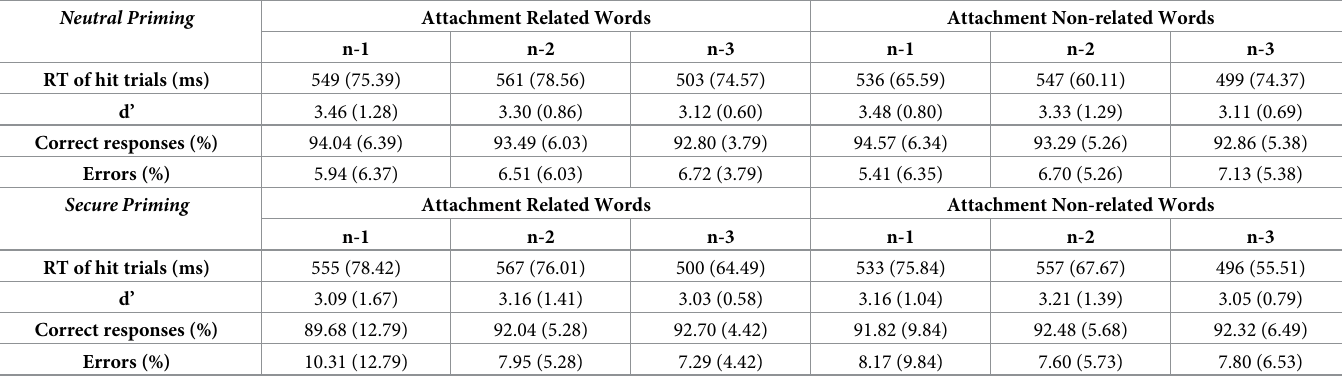
Table 1. The mean values and SDs of the measured variables for the neutral (upper part) and secure priming (lower part) conditions. Neutral